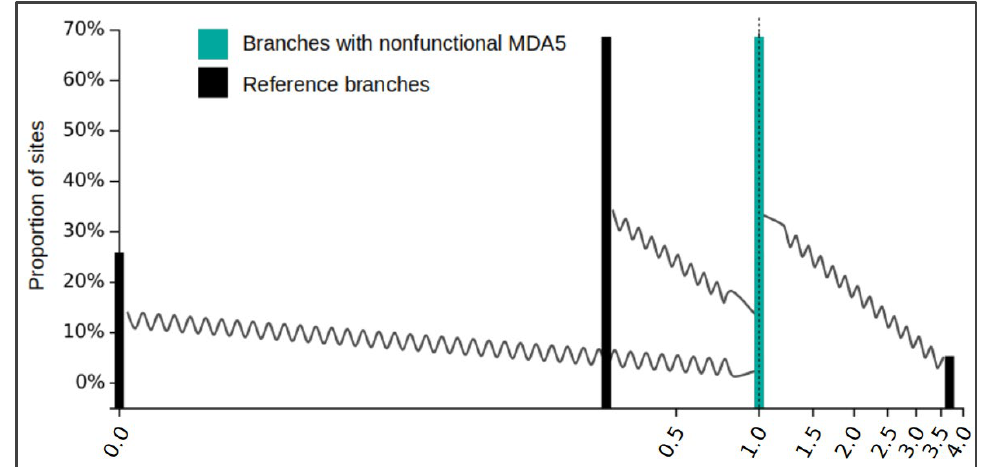
Figure 3. Relaxation of selection in nonfunctional MDA5 avian orthologs. Result of the HyPhy RELAX analysis is shown as a diagram generated by the program. Black bars represent three categories of sites in functional MDA5 avian orthologs with their dN/dS value estimates. Cyan bars (of the same dN/dS value for all three categories in this case), represent sites in disrupted MDA5 avian orthologs described in this study. Shift of cyan bars to dN/dS value of 1 indicates relaxation of selection in tested species. The wavy lines indicate the shift in dN/dS values (for each category) between reference group and test group.